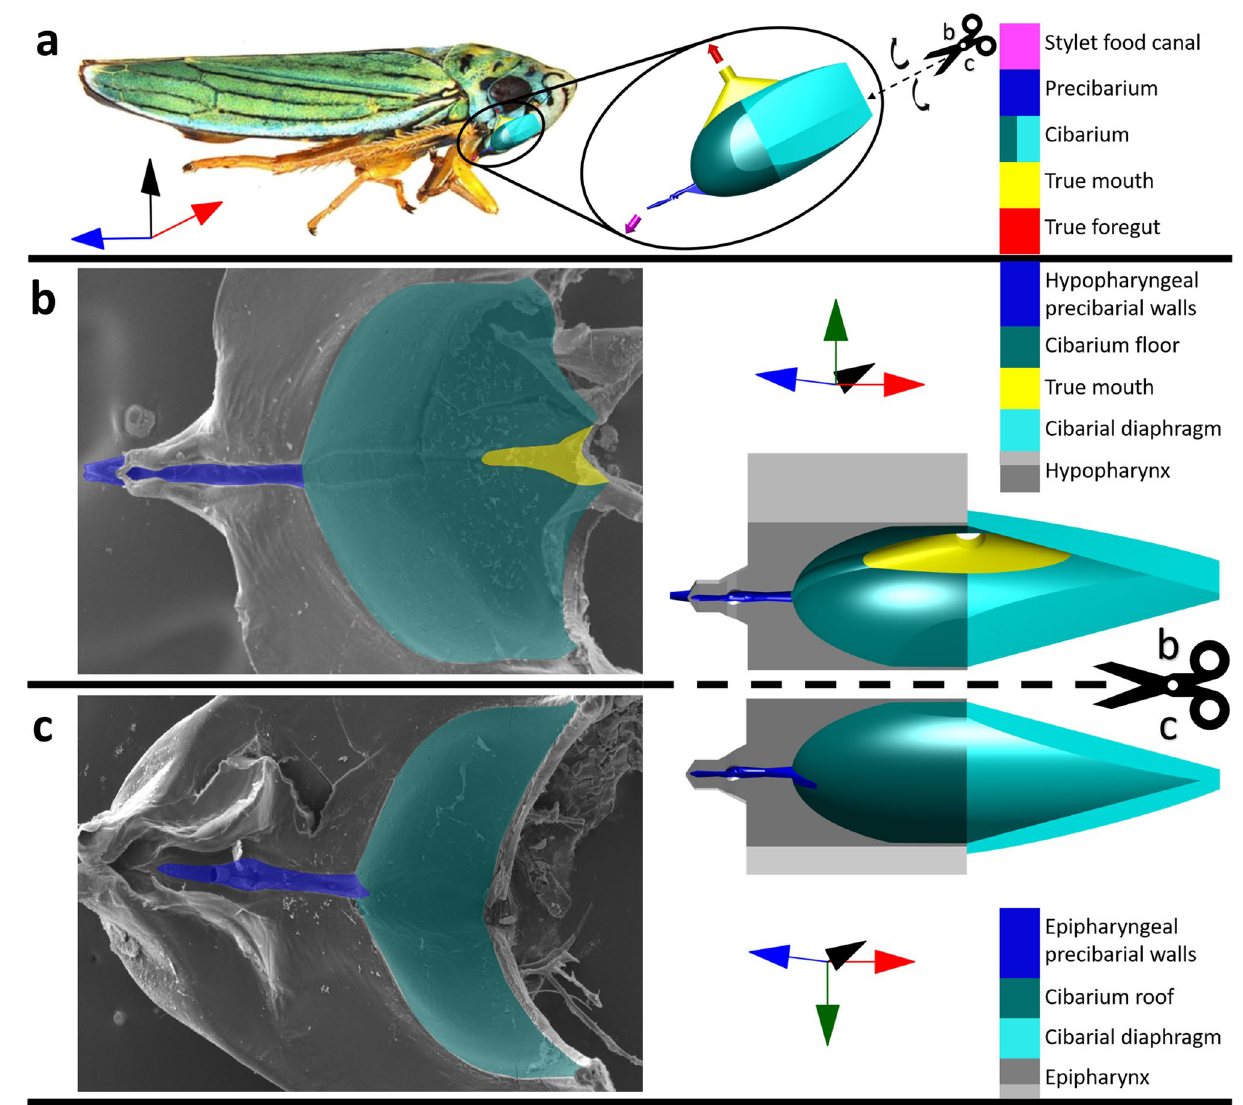
Figure 2. Functional foregut (precibarium and cibarium) of the blue–green sharpshooter, with segments of the 3D model labeled with broad terminology. ( a ) Approximate location/orientation of the functional foregut inside the insect. The 3D model shows an external view of the walls of the precibarium, cibarium, and true mouth, as if the rest of the epipharynx, hypopharynx, and cibarial diaphragm did not exist (convex). The image of the insect is used with the permission of the photographer Emilie Bess (EC Bess, USDA APHIS PPQ). ( b ) Hypopharynx electron microscope image (left) and 3D model segment (right, concave, internal) for comparison. The electron microscope image was adapted from a previous publication (Reprinted with permission; copyright © American Society for Microbiology, [Appl. Environ. Microbiol. 81, no. 23 (2015): 8145–8154 10.1128/AEM.02383–15]). ( c ) Epipharynx electron microscope image (left) and 3D model segment (right, concave, internal) for comparison. The coordinate axes indicate anterior → posterior, distal → proximal (for the trough), ventral → dorsal, and left → right. The relationship between the functional foregut and coordinate axes is different for different sharpshooter species. The scissors and dotted lines indicate where the 3D model in subfigure a would be split to obtain the 3D model segments in subfigures b and c. The associated black curved arrows in subfigure a indicate that the two halves of the split 3D model segment would need to be hinged outward to obtain the views in subfigures b and c. The gray 3D parts of subfigures b and c are semi-abstract representations of the epipharynx and hypopharynx that serve for comparison with their corresponding electron microscope